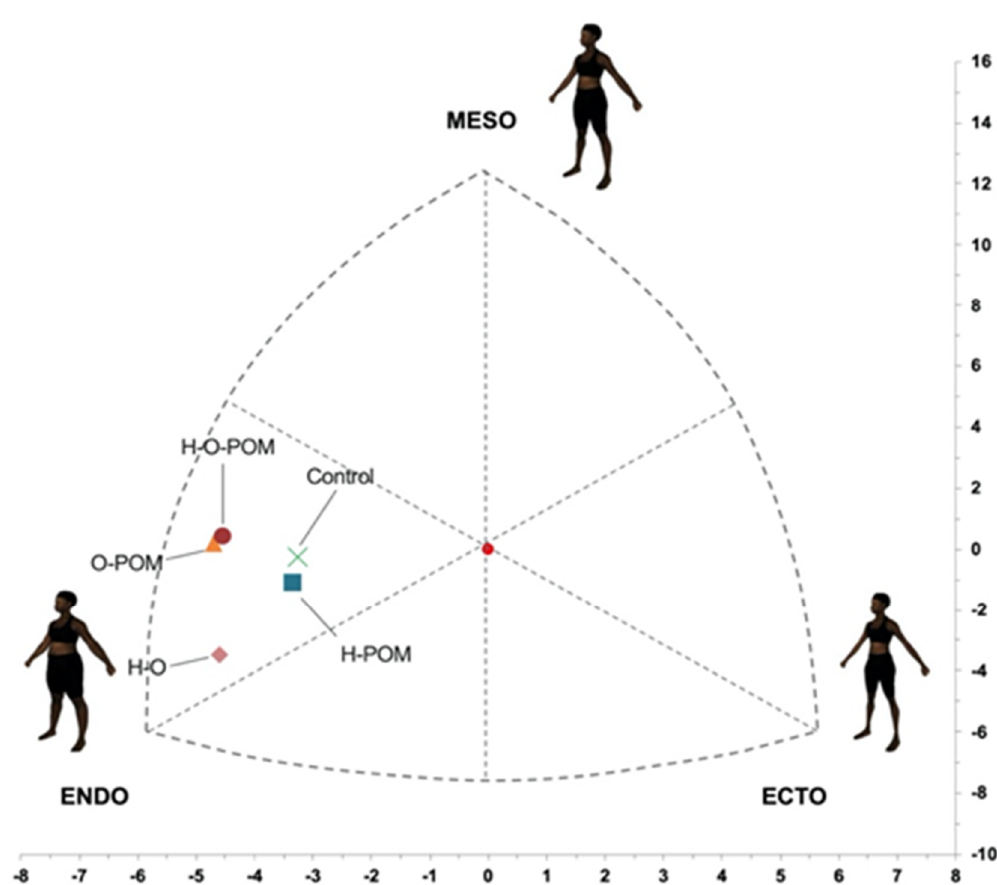
Figure 4. Somatotype distribution (endomorph, mesomorph, ectomorph) seen in this study. Phenotypic: hyperandro- genism [H]; oligo/amenorrhoea [O]; polycystic ovarian morphology [POM]. Body shape types from Hudson et al.[39].